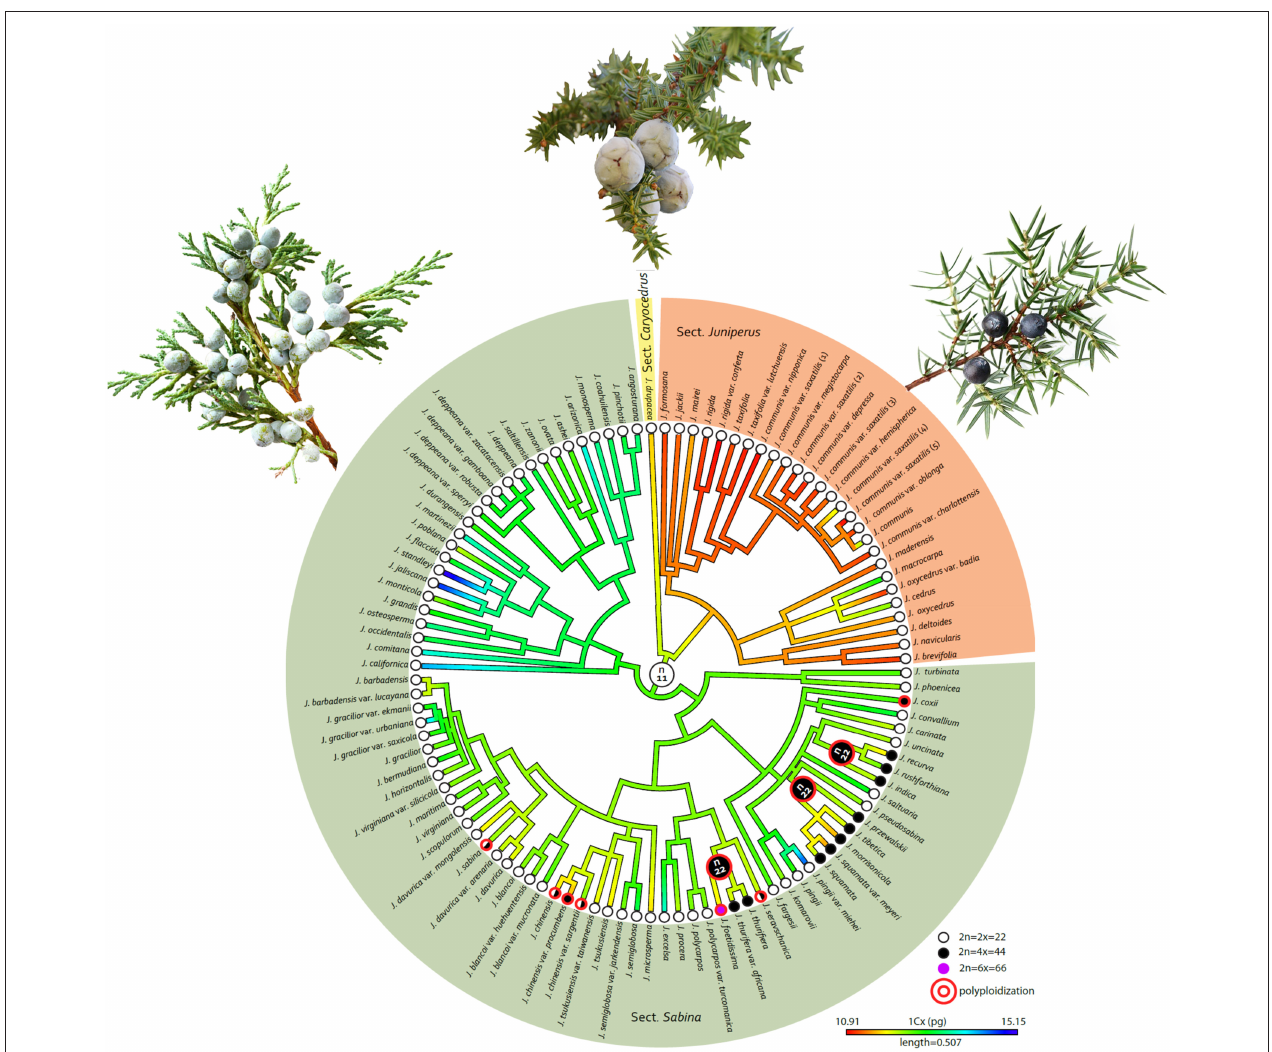
FIGURE 2 | Ancestral state reconstruction of genome size (1C x /pg) and chromosome number (n) on a phylogenetic tree of Juniperus reconstructed using Bayesian approaches ( Adams, 2014). An illustration of the leaf shape for each section is represent by: (a) J. drupacea (sect. Caryocedrus ); (b) J. communis (sect. Juniperus ); (c) J. excelsa (sect. Sabina